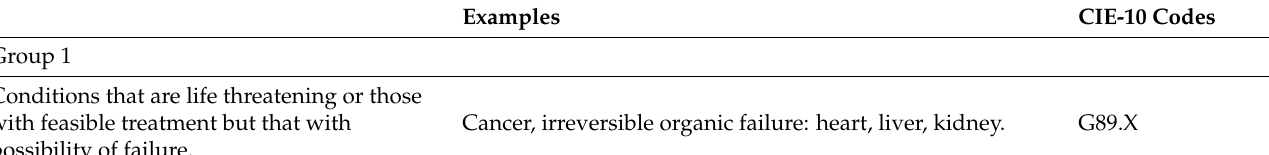
Table 1. Group classification according to Feudtner criteria and